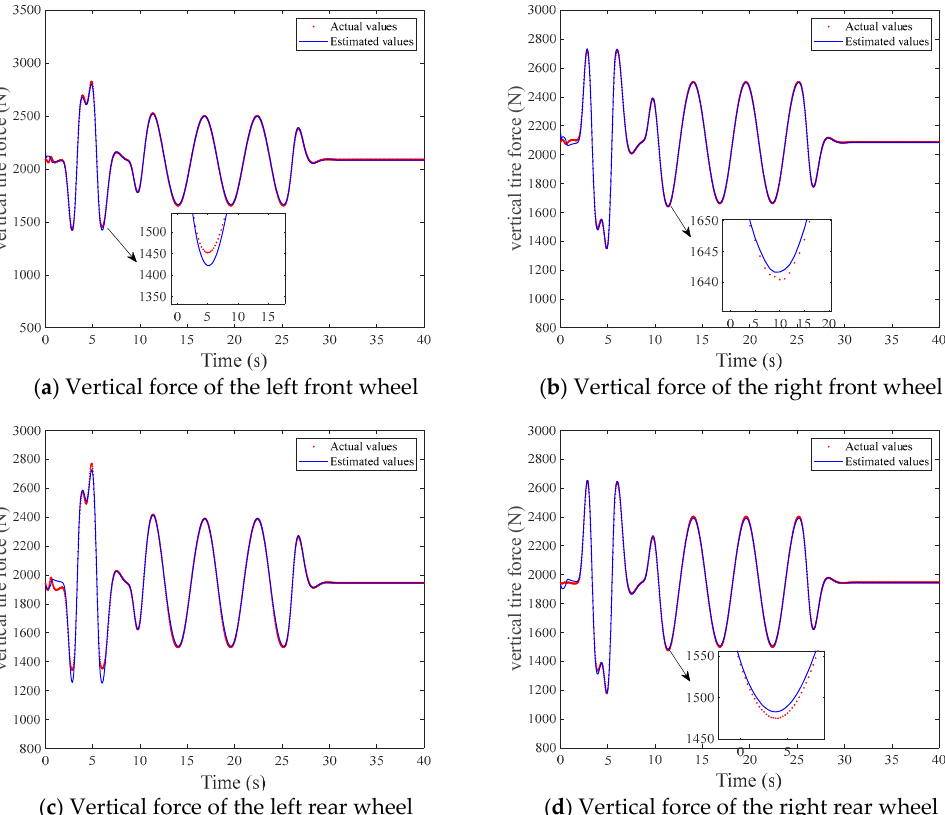
Figure 14. The vertical tire force of the wheels.